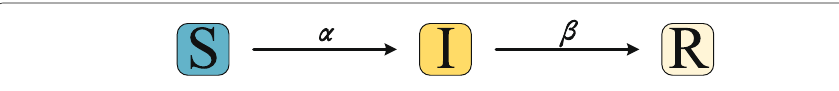
Fig. 2 SIR model. Source: the figure is adapted from Pastor-Satorras et al. [43]